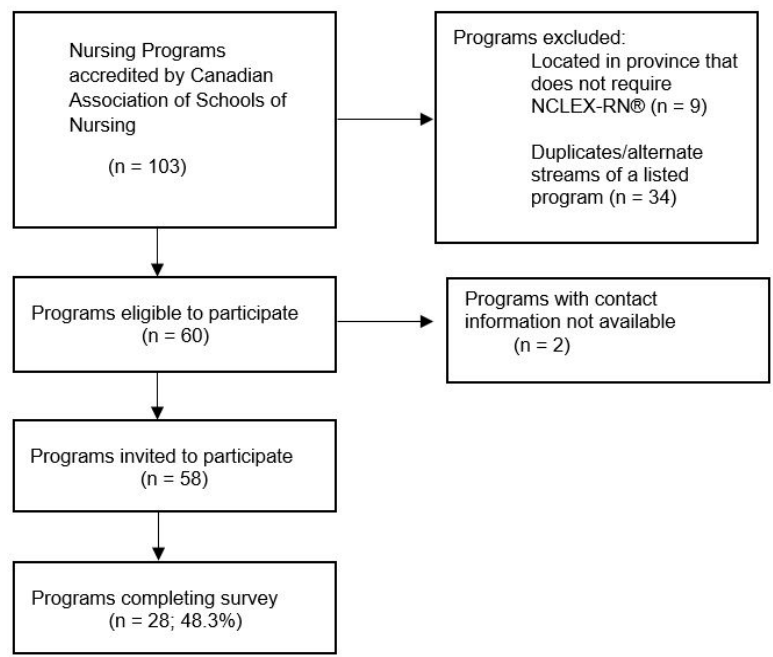
Figure 1. Flow chart of Canadian Nursing Program’s eligibility and participation. Table 1. Summarized specific survey questions .